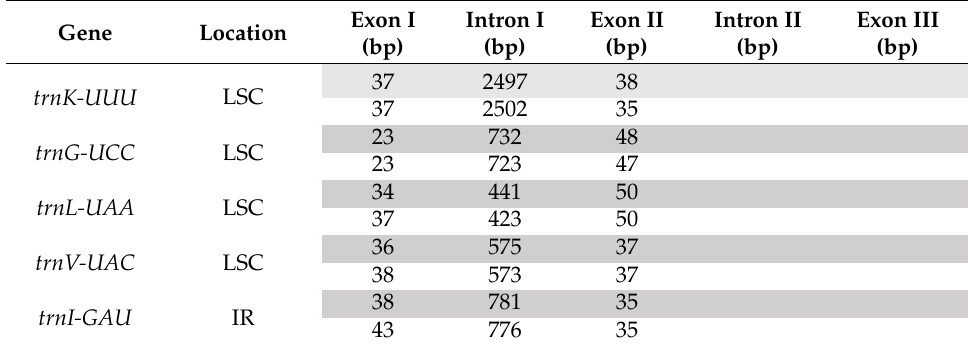
Table 4. A comparison of exon and intron length in genes with introns in the A. tataricus and A. spathulifolius chloroplast